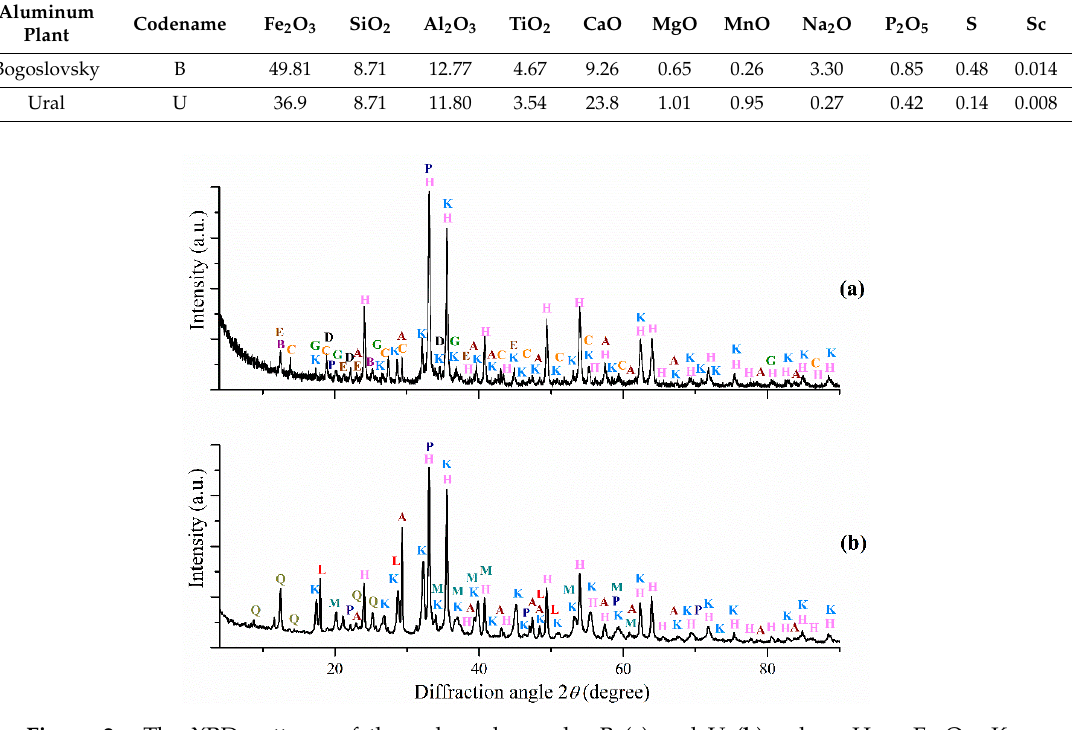
Figure 2. The XRD patterns of the red mud samples B ( a ) and U ( b ), where H— α -Fe 2 O 3 ; K—